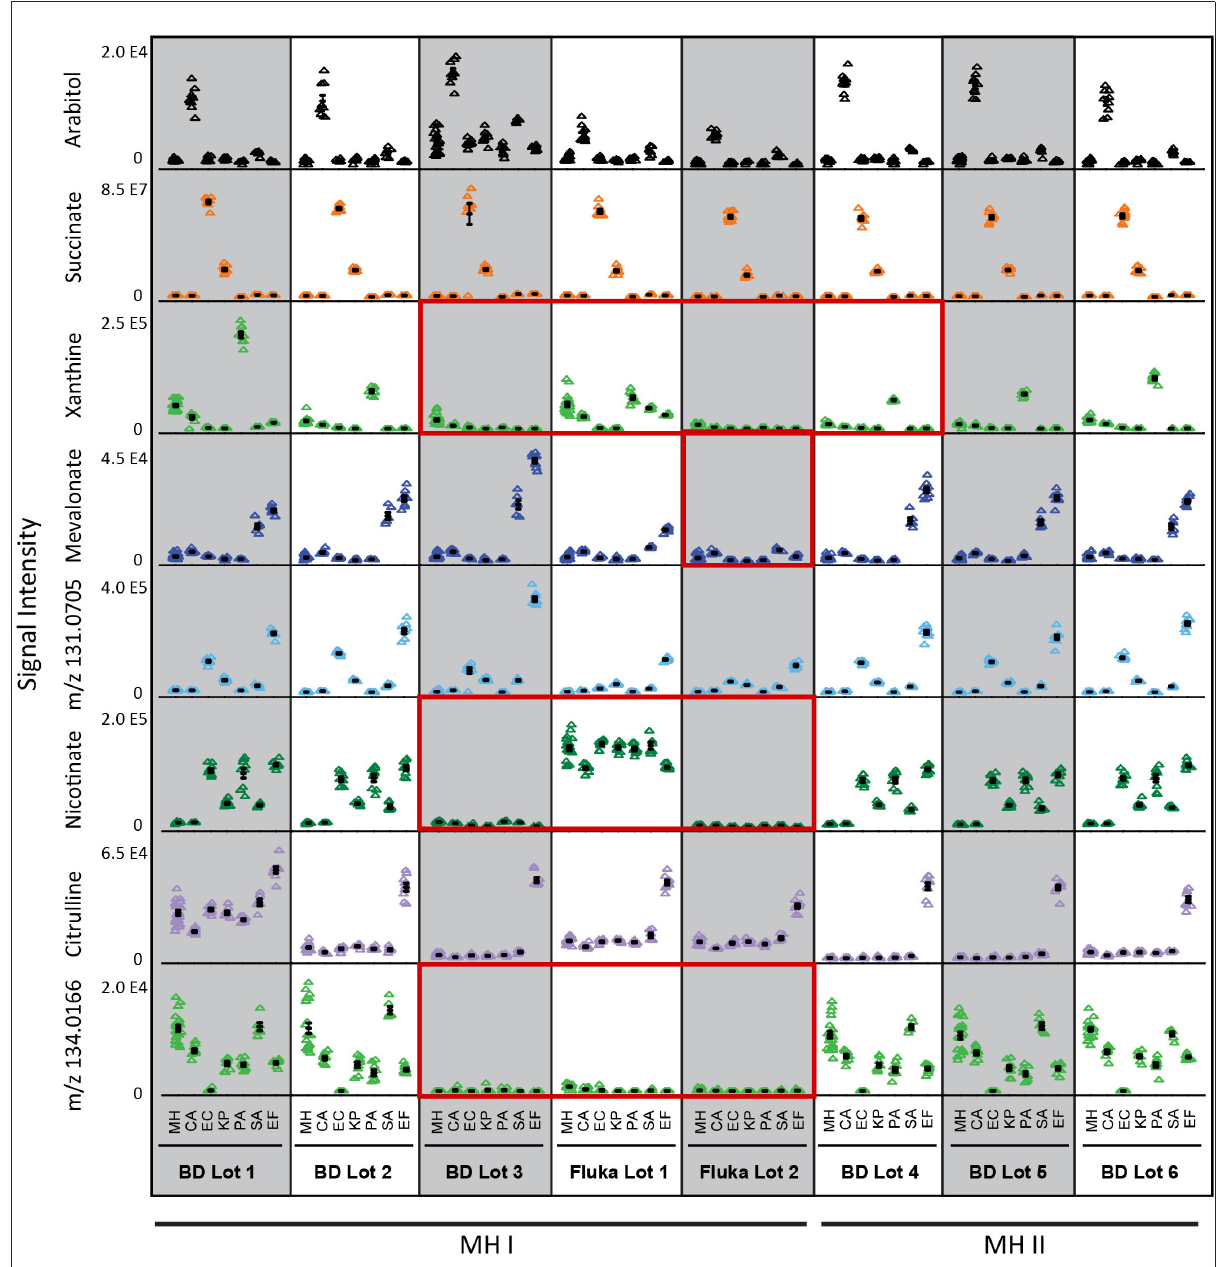
FIGURE2 Differential biomarker production used to differentiate the six common species responsible for bloodstream infections incubated in different batches of MH medium. Three of the eight batches studies (BD Lot 3, and Fluka Lots 1 and 2) showed greatest inconsistencies with regards to species-specific production of xanthine, nicotinate, and mevalonate (Fluka Lot 2 only), and initial medium levels of unassigned marker with m/z 134.0166 (Source Data File 2). Key biomarkers that are affected by certain lots of media have been highlighted in red boxes. MH, Mueller Hinton medium; CA , Candida albicans ; KP , Klebsiella pneumoniae ; EC , Escherichia coli ; PA , Pseudomonas aeruginosa ; SA , Staphylococcus aureus ; EF , Enterococcus faecalis . Data represents n = 9 biological replicates.